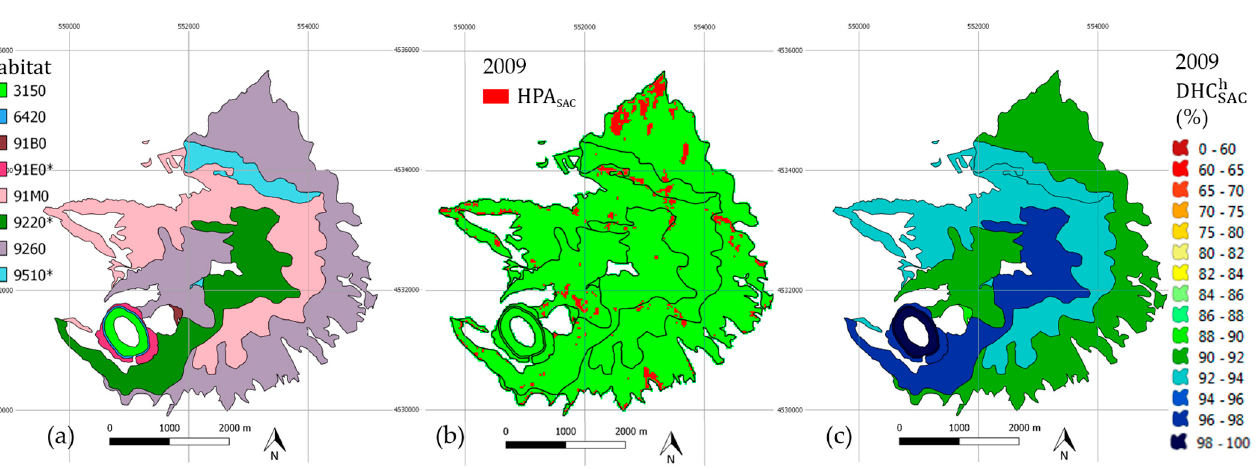
Figure 5. Monte Vulture SAC: ( a ) Maps of relative anomalies (2009); zoom of negative anomalies superimposed on the orthophoto within ( b ) habitat 9260 ( Castanea sativa woods ) due to abandon- ment of marginal areas and bad management of forest areas; ( c ) habitat 9510* ( Southern Apennine Abies alba forests ) due to grazing pressure and unfavorable biotope conditions; ( d ) habitat 91B0 ( Thermophilous Fraxinus angustifolia woods) due to tourism flows favoring the growth of synan- thropic and alien species. As for habitat 9510* ( Southern Apennine Abies alba , cyan in Figure 4a), two different patches can be distinguished. The first one is a very small area located at the center of the site. Here, trees grow under good conditions (Figure 5a), whereas the second one is vast